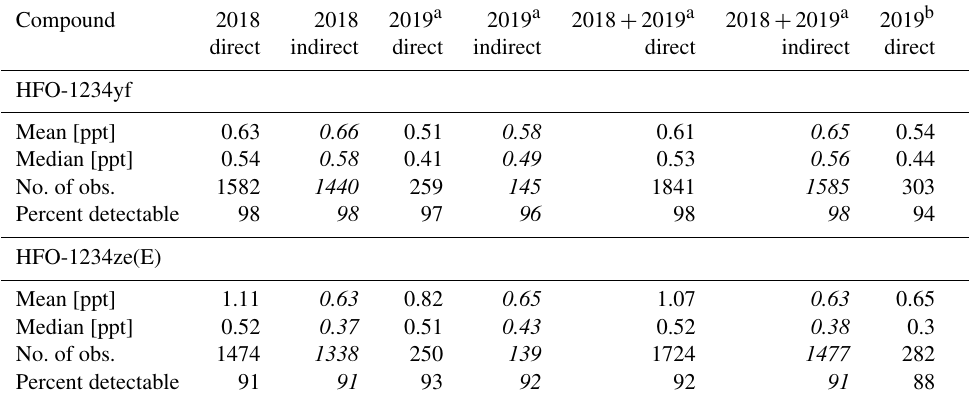
Table 5. Same as Table 4 but for the continuous in situ measurements at TOB from May 2018 to May 2019 for HFO-1234yf and HFO- 1234ze(E). The indirect mole fraction estimations from May 2018 to March 2019 are based on HFC-152a as main reference substance and PFC-318 as evaluation substance. The limits of detection (LODs), which are calculated as the 1.5-fold noise of each chromatogram, are 0.02ppt for HFO-1234yf and 0.01ppt for HFO-1234ze(E) for the in situ measurements.